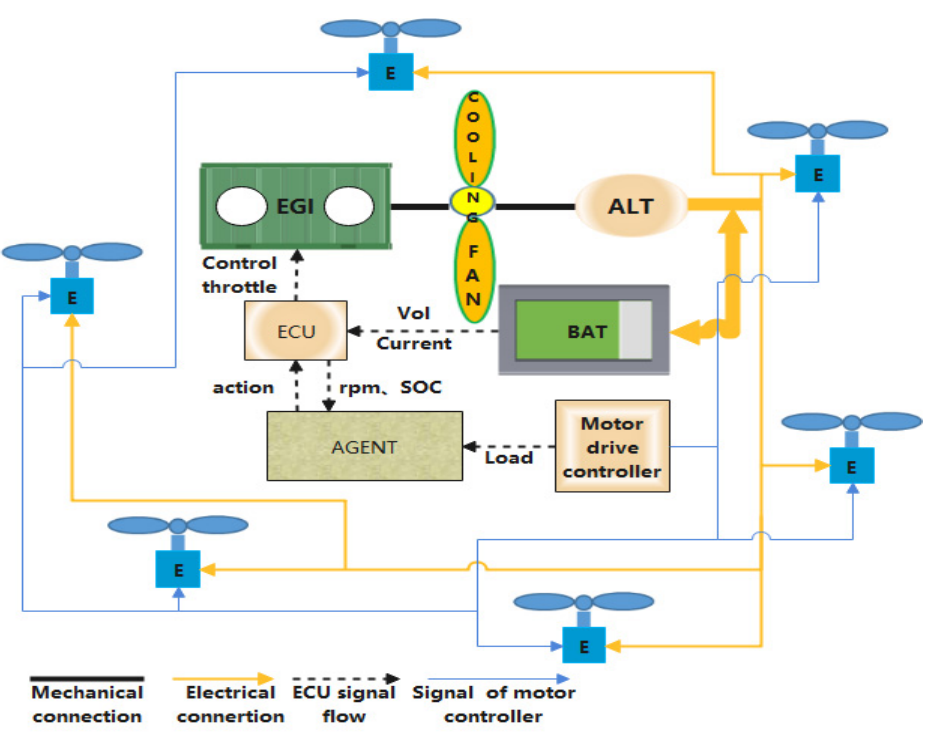
Figure 1. Propulsion system architecture of the UAV. Table 1. Main design parameters of the system.